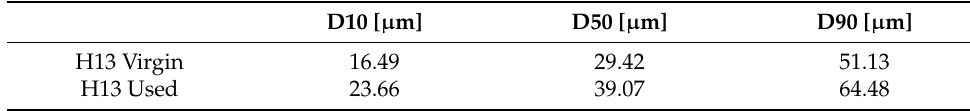
Table 3. Mean particles size of powder